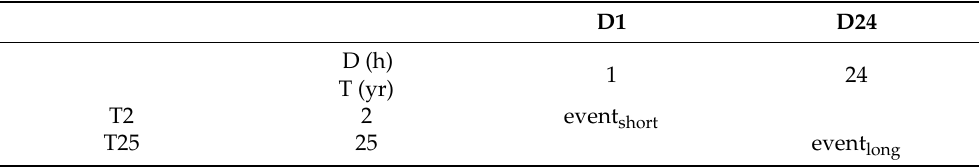
Figure 1. Location of 21 weather stations across Taiwan for the northern, central, southern and eastern regions. Table 1. Contingency table of the six types of events analyzed in this study (event short , event long , D1, D24, T2 and